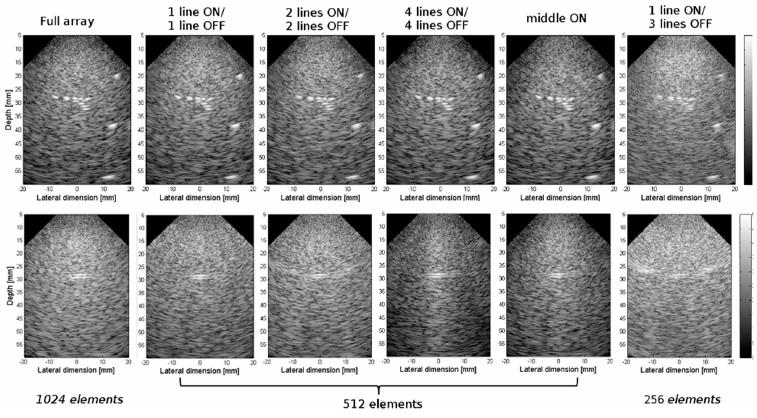
Figure 6. Experimental data acquired with 9 DW on a “grape” wire phantom. Different configurations of the US array were used: full array, 1 line ON-1 line OFF, 2 lines ON-2 lines OFF, 4 lines ON-4 lines OFF, middle ON and 1 line ON-3 lines OFF. The shown planes ( x , z ) (first row) and ( y , z ) (second row) are taken in the center of the US device. A dynamic of 50 dB has been used in all the images.